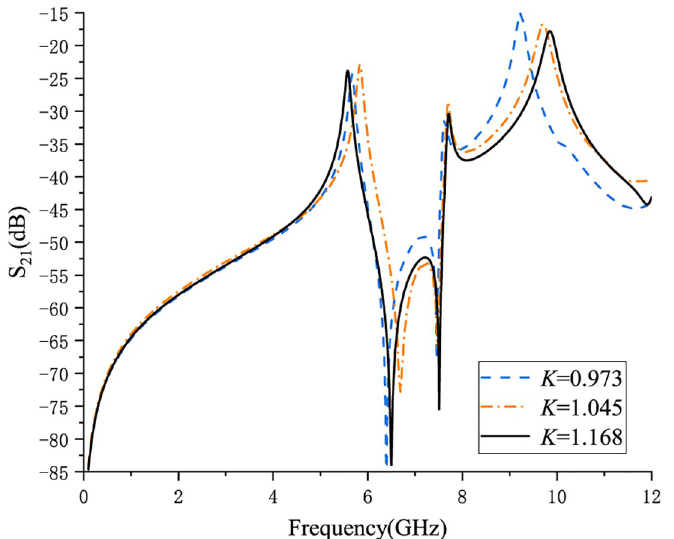
Fig 5. Coupling comparison curves of different K